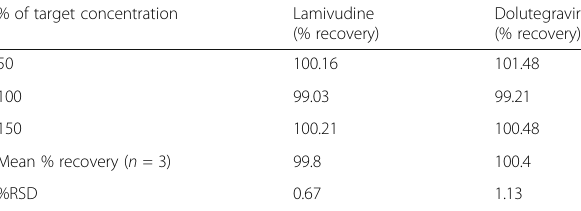
Table 6 Results of accuracy study